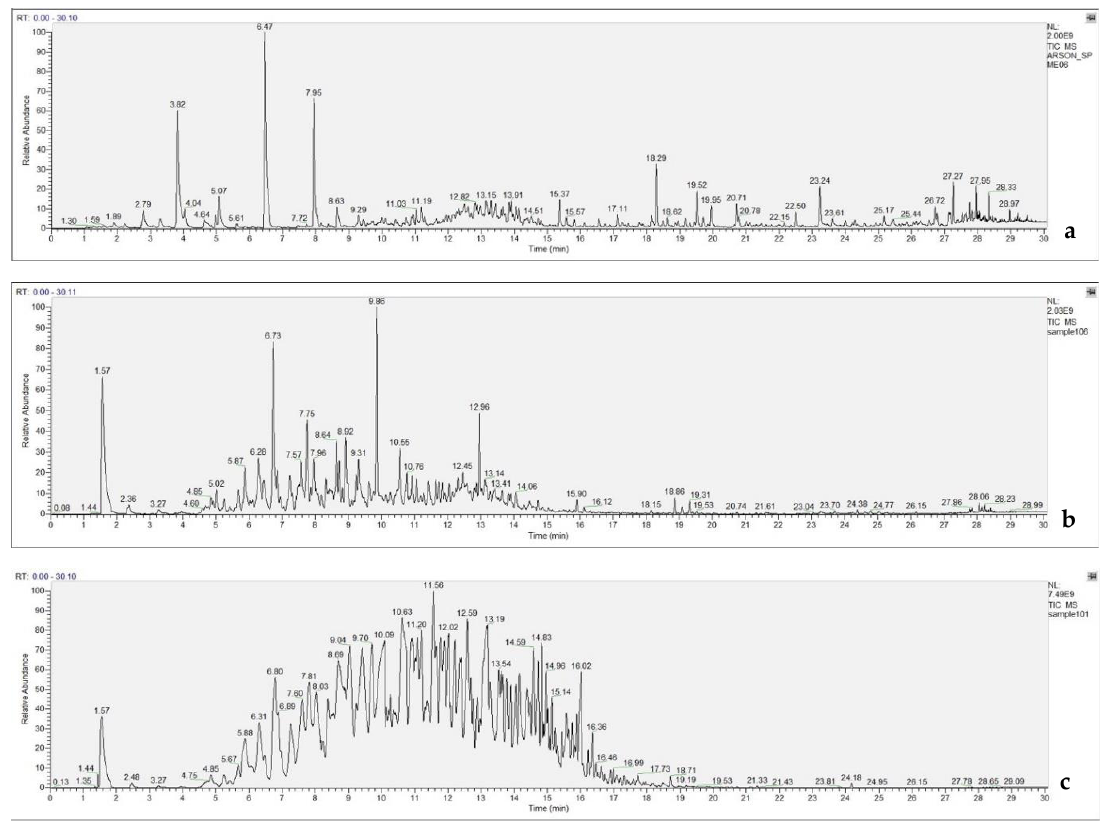
Figure 7. Total ion chromatograms ( m / z 50–500) of ( a ) carpet #1, burned without ILs; ( b ) carpet #1 burned with kerosene; and ( c ) neat kerosene.